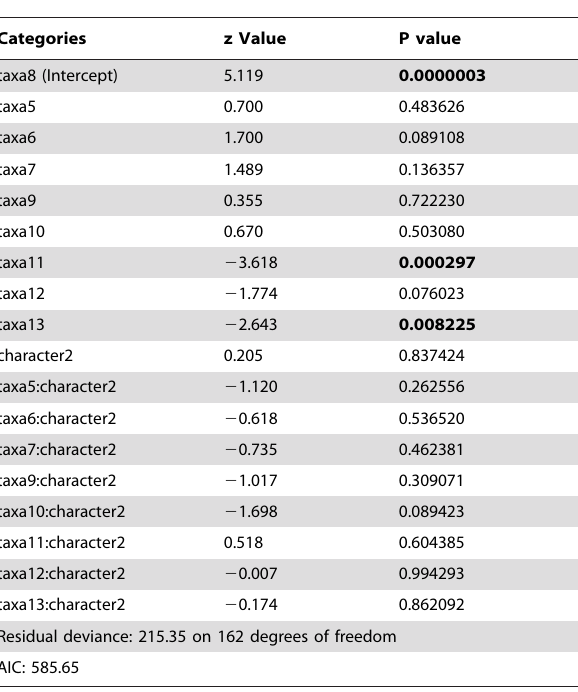
Table 4. Results of the Generalised Linear Model analysis with all the pairwise comparisons between taxa5 and the other eight taxa groups and their interactions with character sets.